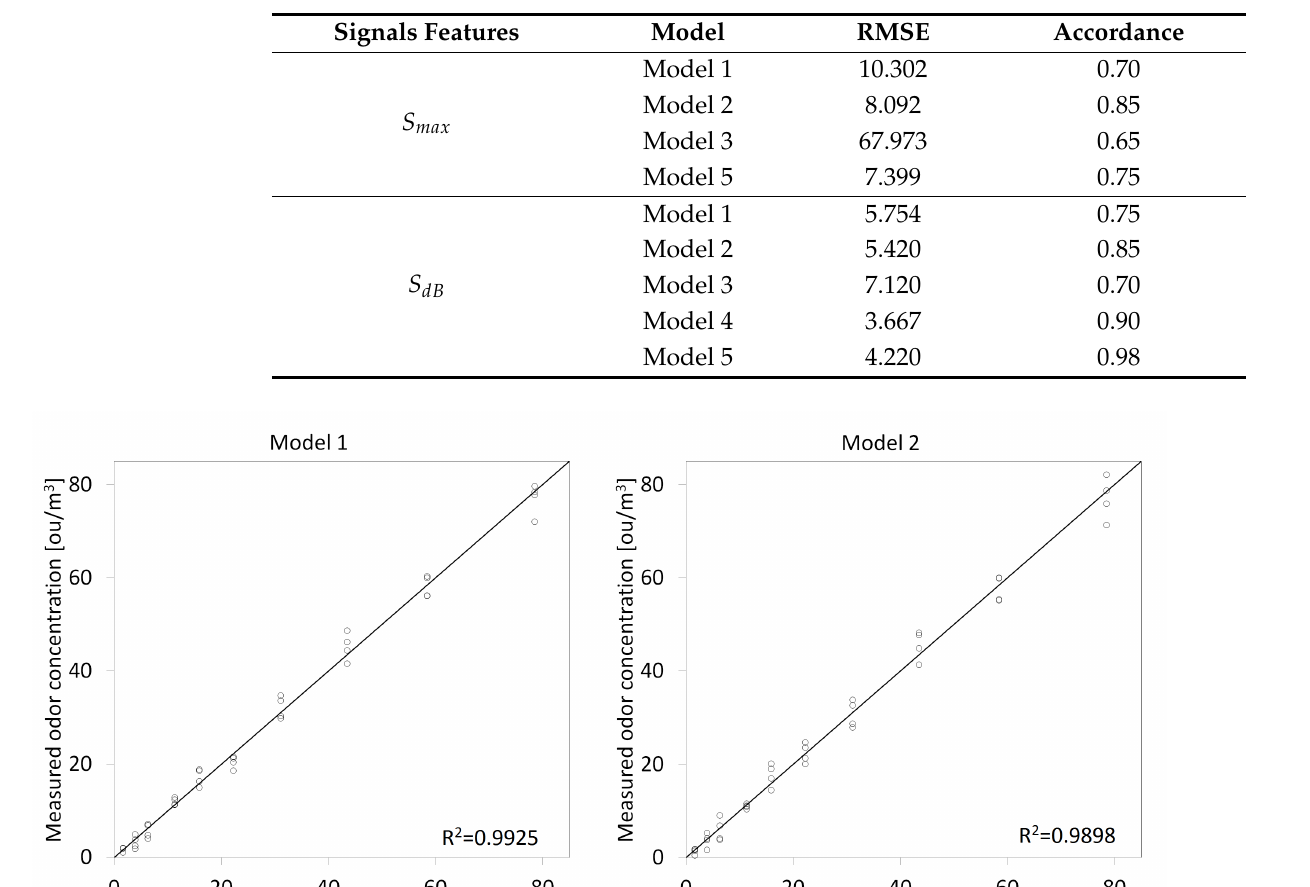
Table 5. Accordance and RMSE for prepared models.